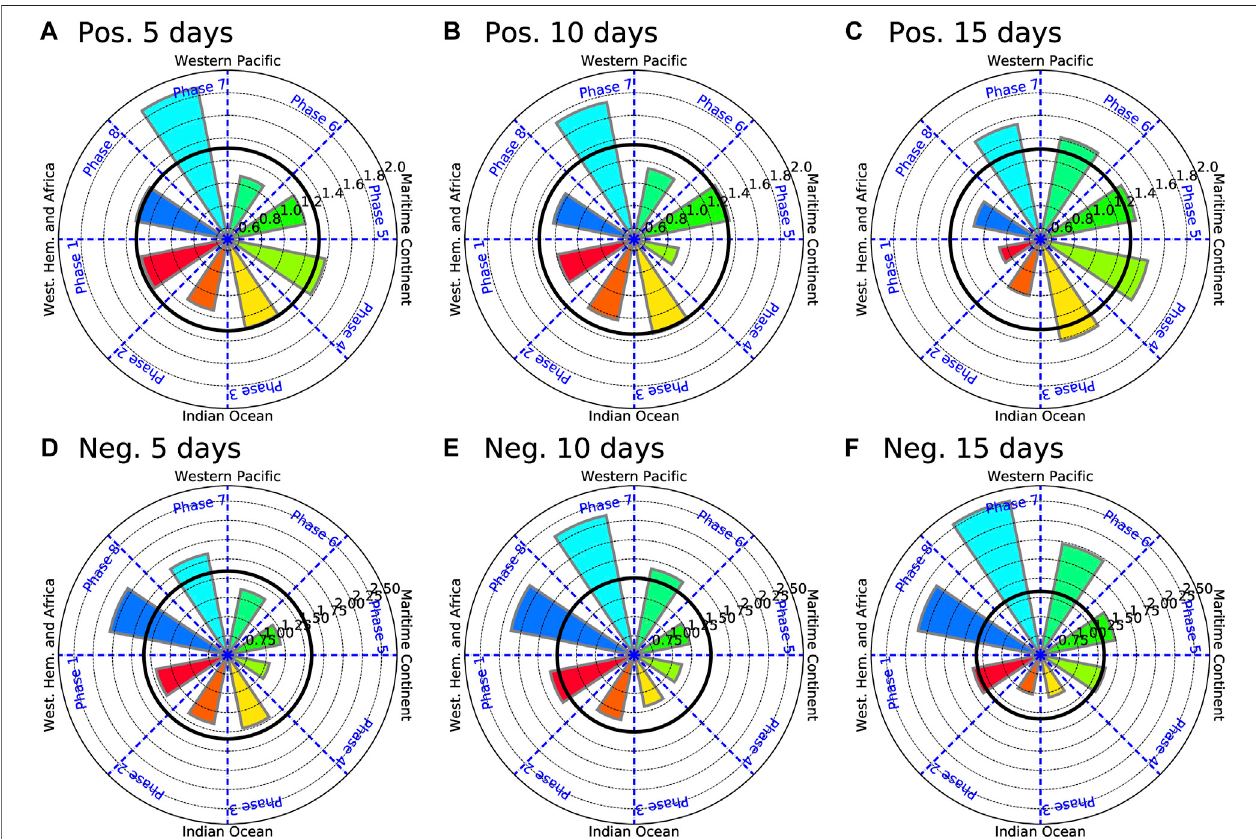
FIGURE 6 | Time-lag composites of Arctic Oscillation (AO) amplitudes (bars) in eight phases of the Madden – Julian Oscillation (MJO) leading the AO activity for 5 (left panels A and D) , 10 (middle panels B and E) , and 15 (right panels C and F) days. The composite of the AO amplitude without the leading MJO is shown by the circle of black solid line in each panel, and the gray dash lines are reference lines for the strength of AO amplitude. The grid space of gray dash lines in the top (bottom) panels is 0.2 (0.25). The blue dash lines separate the eight MJO phases, and the composites of AO amplitude in MJO 1 – 8 phases also present different colors.